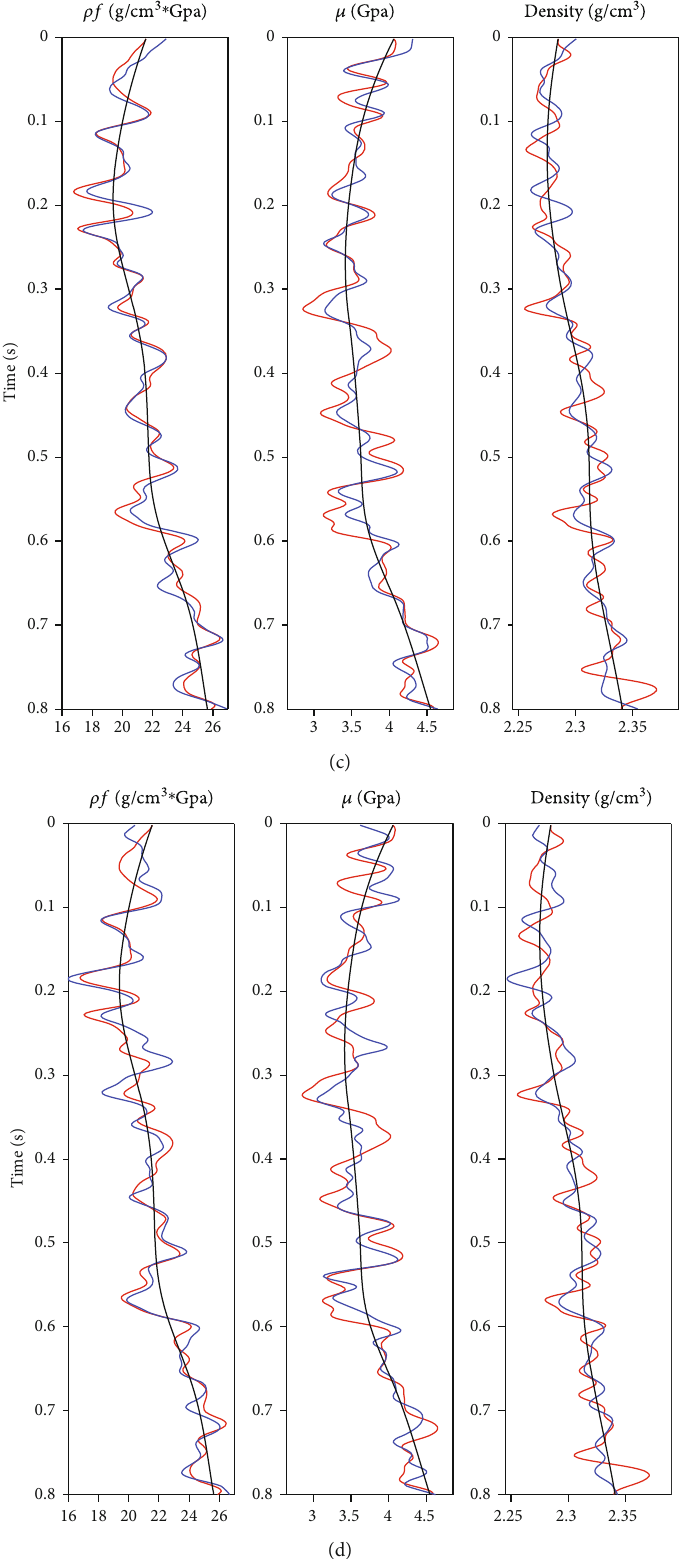
Figure 5: Inversion results of synthetic data with di ff erent SNR. The black line indicates the initial model, the blue line indicates the inversion result, and the red line indicates the true data. (a) Noise-free, (b) SNR = 2 , (c) SNR = 1 , and (d) SNR = 0 : 5